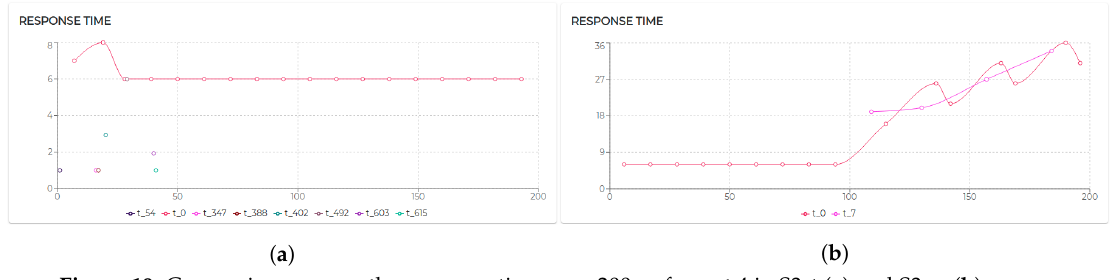
Figure 19. Comparison among the response time over 200 s of agent 4 in S3rt ( a ) and S3gp ( b ); y-axes: response time (seconds); x-axes: time (seconds).